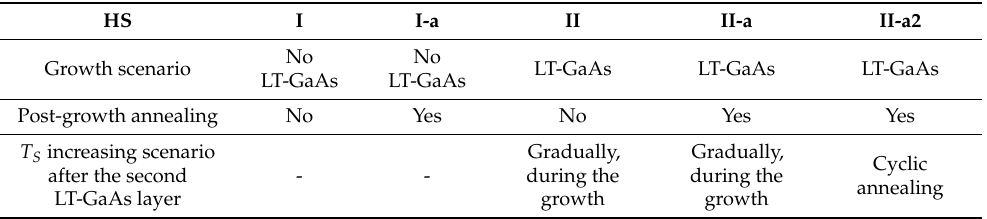
Table 1. Key parameters of the growth of GaAs/Si HSs. HS I I-a